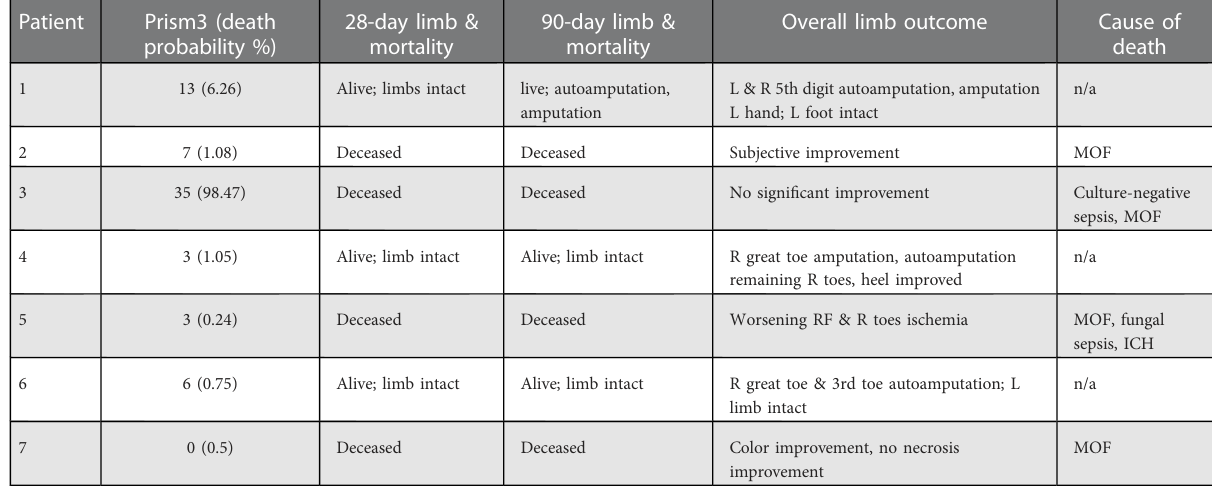
TABLE 5 Outcome data.